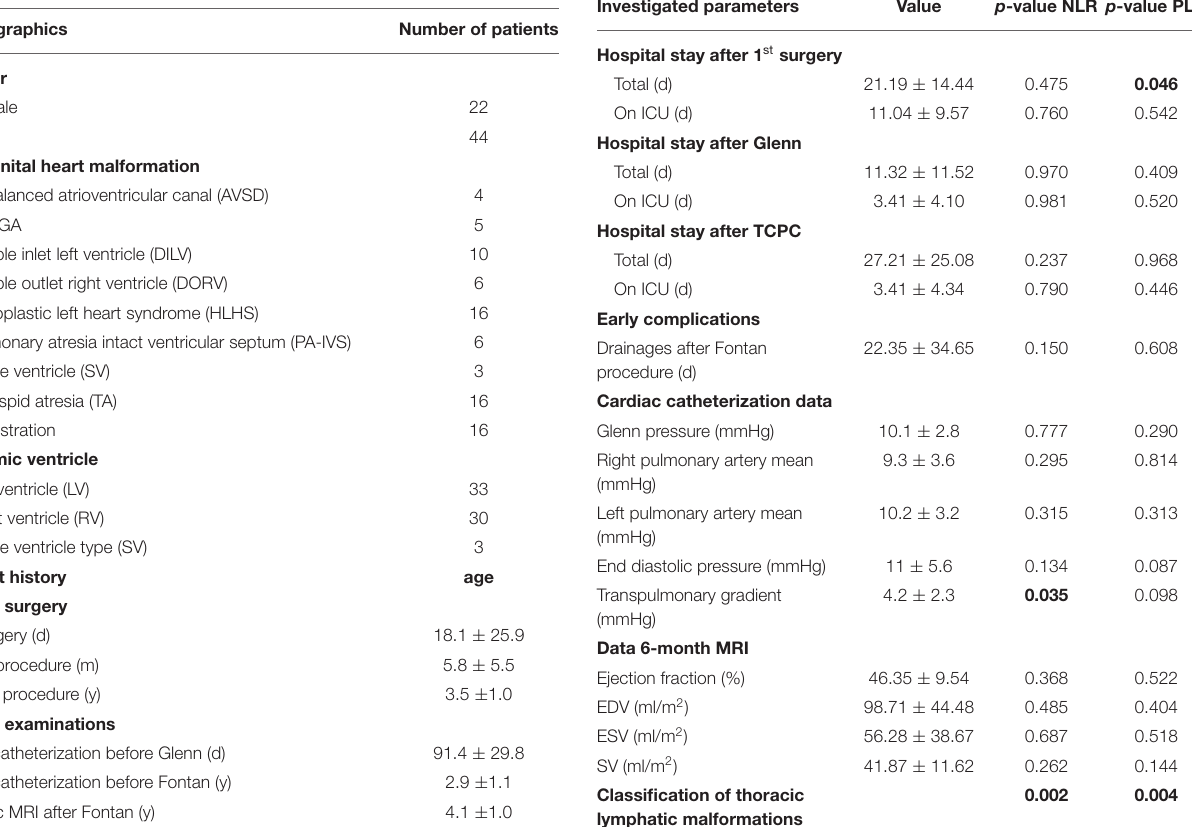
TABLE 1 | Patient demographics, cardiovascular malformation, and patient history.